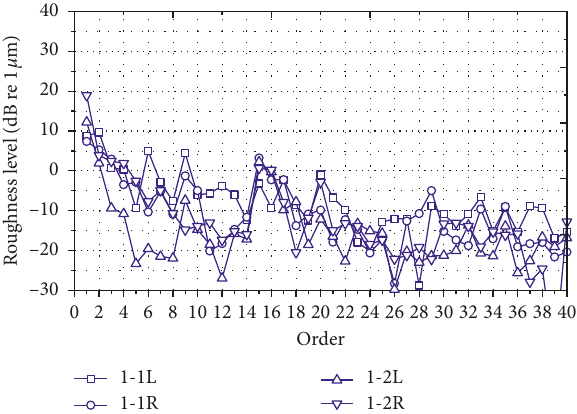
Figure 4: Spatial spectrum of wheel irregularity obtained on the test vehicle after